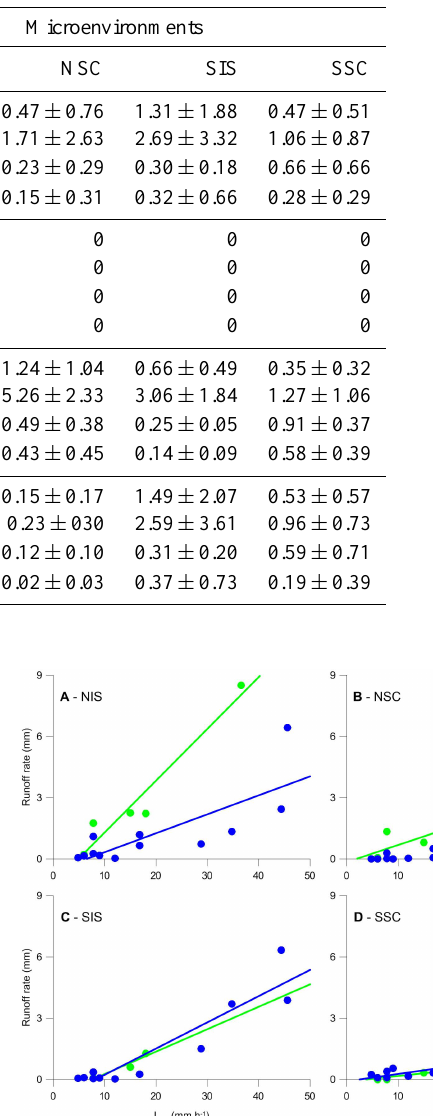
Table 4. Summary of precipitation and soil hydrological and erosive response. NIS: north-facing inter-shrub; NSC: north-facing shrub- covered; SIS: south-facing inter-shrub; SSC: south-facing shrub-covered; R r : runoff rate; R c : runoff coefficient; S c : sediment concentration; S l : soil loss.